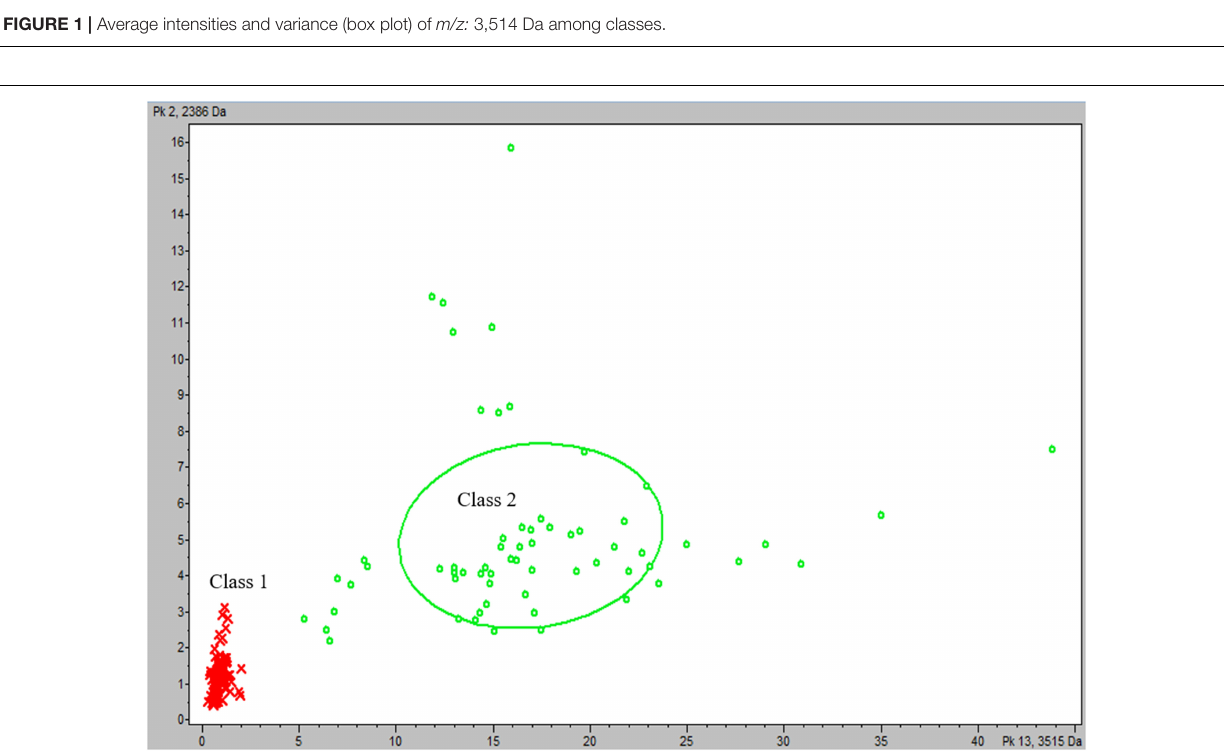
FIGURE 2 | Scatter plot of reference group spectra from classes according to the most discriminating peaks at m/z : 3,515 and 2,386 Da. Class 1 ( M. africanum , M. bovis , M. bovis BCG, M. canettii , and M. tuberculosis Lineage 1): red cross and Class 2 ( M. tuberculosis Lineages 2, 3, and 4): green circle.